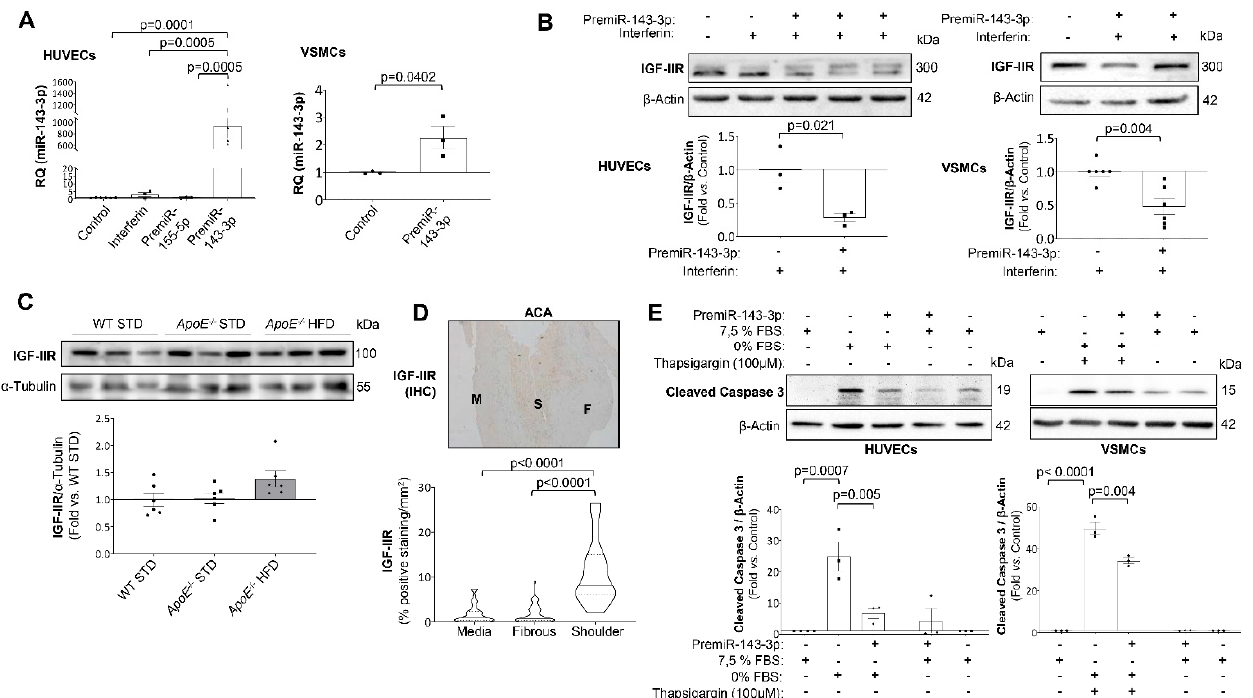
Figure 7. miR-143-3p protects against apoptosis in endothelial and vascular smooth muscle cells by targeting IGF-IIR. ( A ) Relative quantification of the expression levels of miR-143-3p in transfected HUVECs ( left ) and VSMCs ( right ). ( B ) Representative Western blot images of IGF-IIR expression ( upper ) and their quantification ( lower ) in transfected HUVECs ( left panels) and VSMCs ( right panels). ( C ) Representative Western blot images of IGF-IIR expression ( upper ) and their quantification ( lower ) in murine aorta samples. ( D ) Representative immunohistochemical analysis of IGF-IIR expression in advanced carotid atherosclerosis patients ( upper ) and its quantification ( lower ) expressed in %positive staining/mm 2 in the different areas of the atherosclerotic plaque. Magnification 40× (scale bar = 200 µm). ( E ) Representative Western blot images of active caspase 3 ( upper ) and their quantification ( lower ) in transfected HUVECs following serum deprivation ( left ) and transfected VSMCs following thapsigargin exposure ( right ). HUVECs = human umbilical vein endothelial cells; VSMCs = vascular smooth muscle cells; IGF-IIR= insulin-like growth factor type 2 receptor; WT = Wild type group; STD = standard type diet; ApoE − / − = ApoE deficient mice; HFD = high fat diet; IHC = immunohistochemistry; M = media; F = fibrous; S = shoulder; FBS = foetal bovine serum. All the in vitro experiments have been performed at least 3 times ( n = 3). Western blot of IGF-IIR: WT STD 18 wks ( n = 6); ApoE − / − STD 18 wks ( n = 6); ApoE − / − HFD 18 wks ( n = 6). Immunohistochemistry of IGF-IIR: Media ( n = 44); Fibrous ( n = 49); Shoulder ( n = 19).